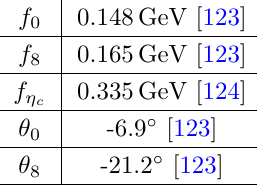
Table 9 . Decay constants and angles for (cid:17) , (cid:17) 0 and (cid:17) c .